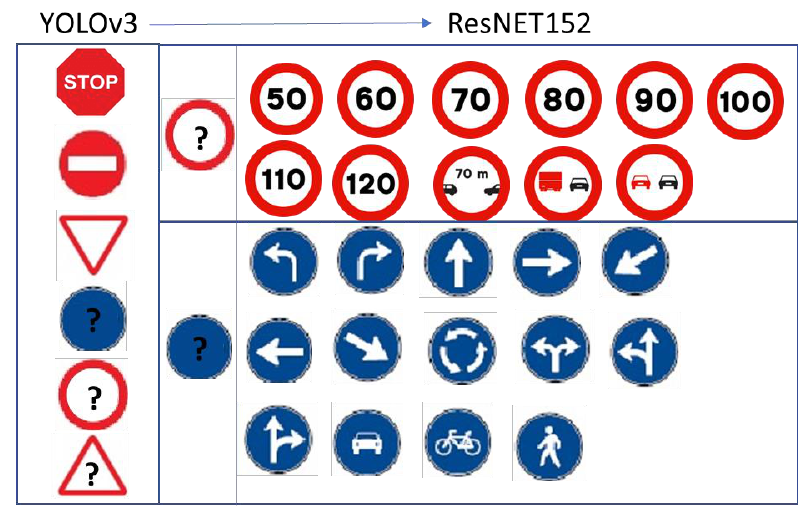
Figure 5. Classes and subclasses of the traffic signs selected.